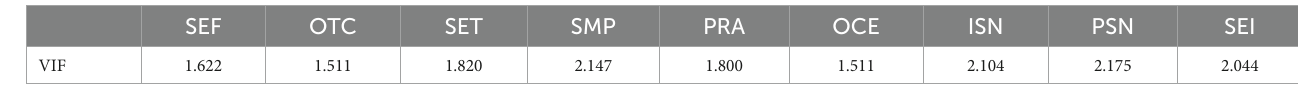
TABLE 1 Full collinearity